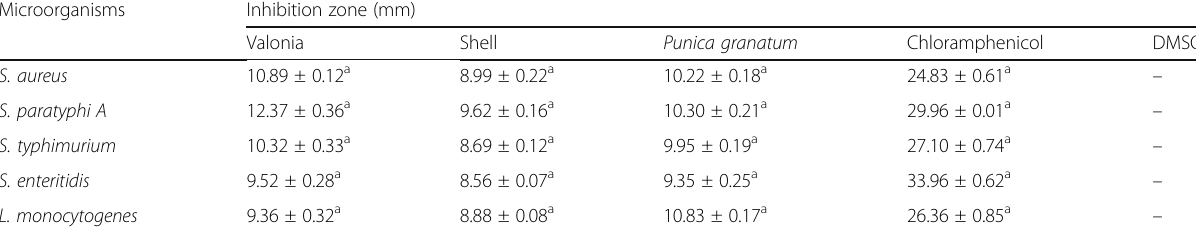
Table 4 Antibacterial activities of ethanol extracts of valonia and shell from Q. variabilis